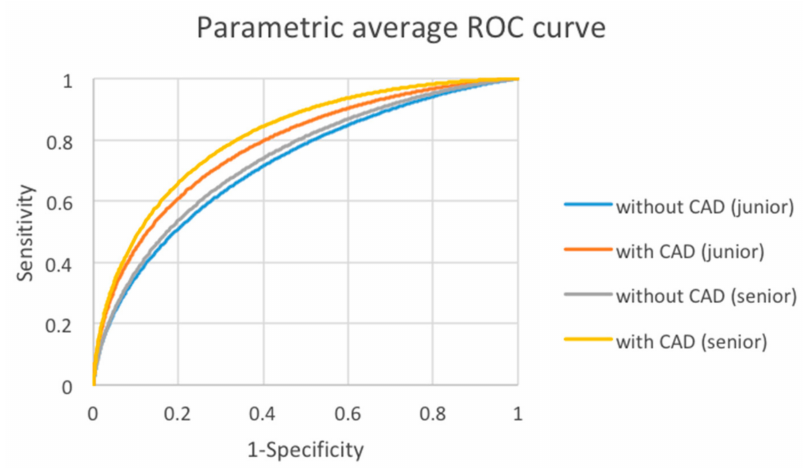
Figure 3. Average AUC Without and With CAD of junior group and senior group. Blue = junior group without CAD; Orange = junior group with CAD; Gray = senior group without CAD; Yellow = senior group with CAD.